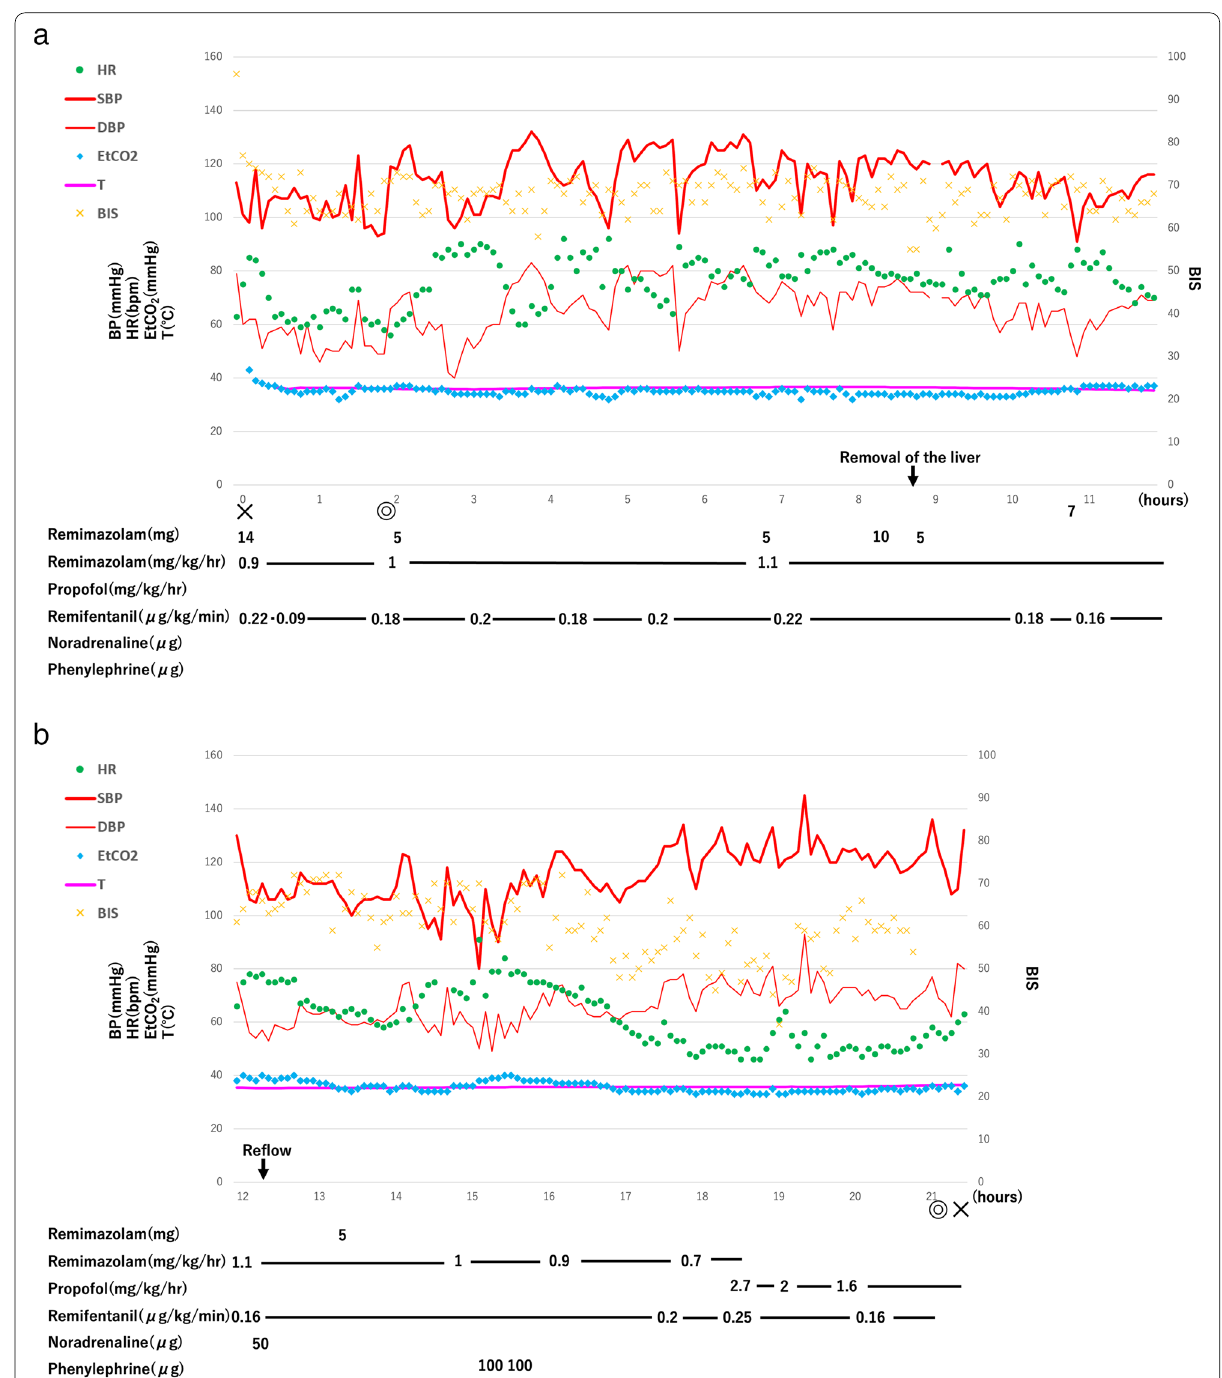
Fig. 1 Anesthesia records. a The first of two anesthesia records and b the second. X: start of anesthesia and end of anesthesia, ◎ start of surgery and end of surgery. HR heart rate, SBP systolic blood pressure, DBP diastolic blood pressure, EtCO 2 end tidal CO 2 , T rectal temperature, BIS